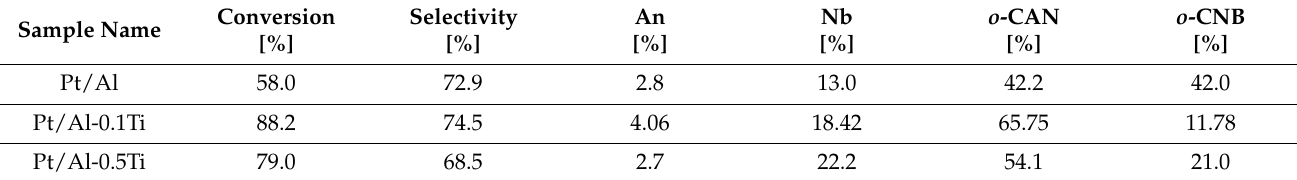
Table 4. Conversion and selectivity of o -CNB hydrogenation reaction, percentage of components in the post-reaction